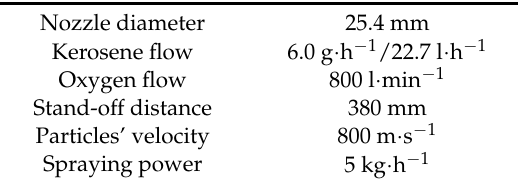
Table 3. Spraying